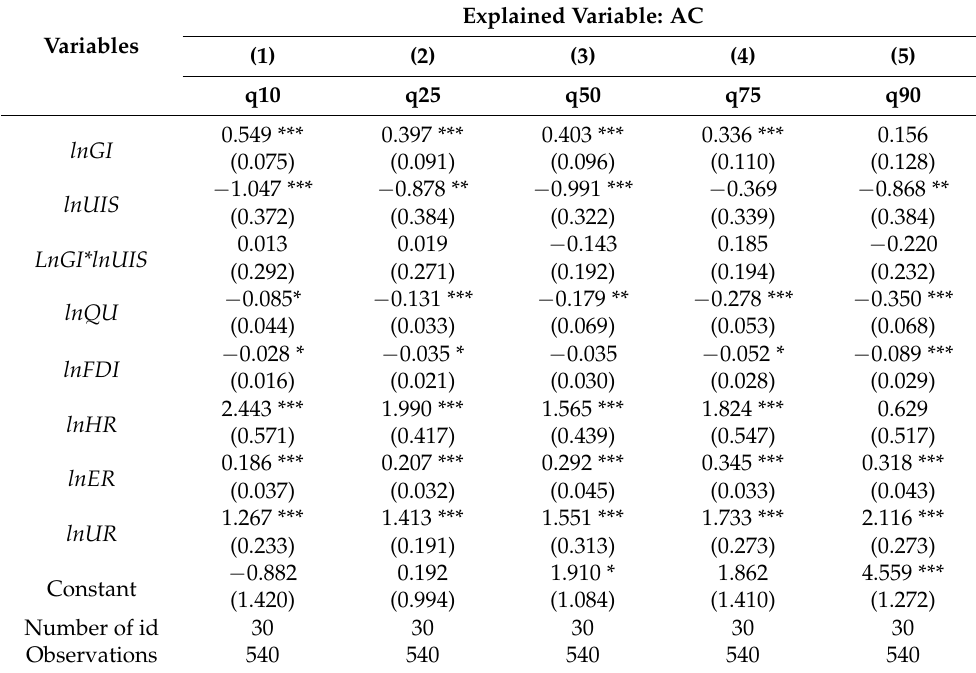
Table 10. Panel quantile regression results for the upgrading of the industrial